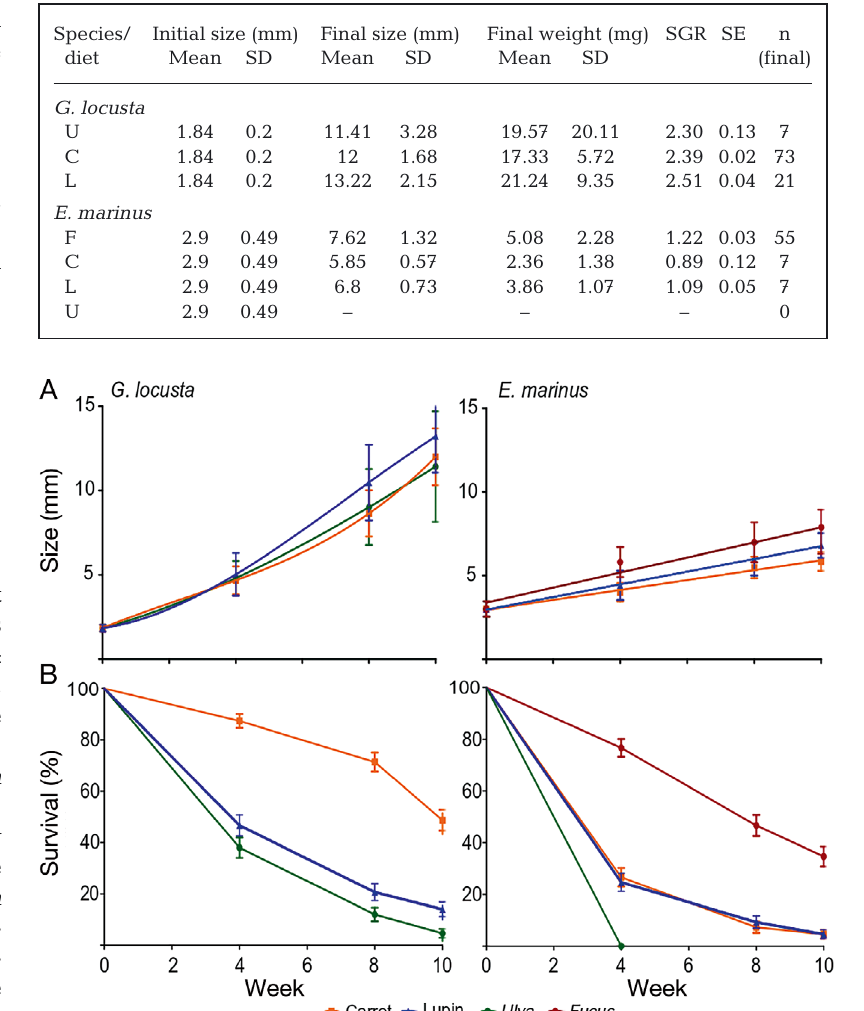
Table 1. Growth parameters of Gammarus locusta and Echinogammarus marinus in response to different diets (U: Ulva ; F: Fucus ; C: carrot leaf, L: lupin meal). Spe-